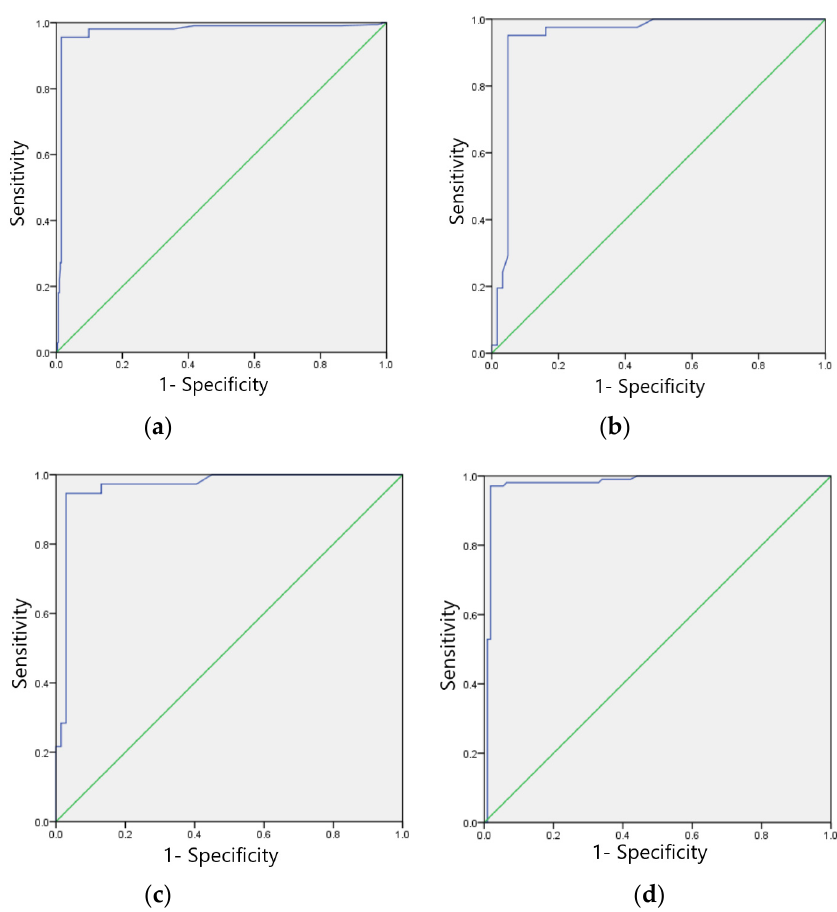
Figure 6. ROC curves of training sets of four typical anomaly categories: ( a ) Sinus bradycardia; ( b ) Sinus tachycardia; ( c ) Myocardial ischemia; ( d ) Nonspecific intraventricular conduction delay. Table 8. Evaluation of the effect of the ECG category recognition test